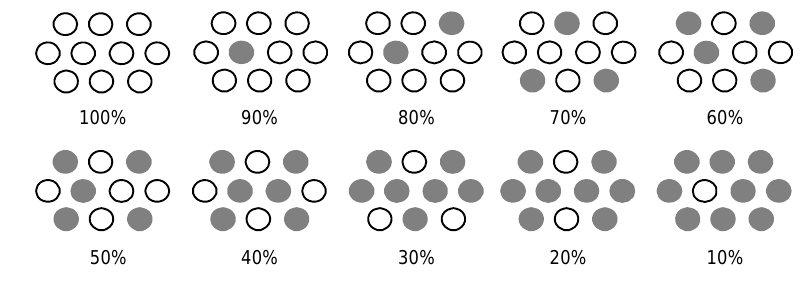
Figure 14. Typical arrangements of the dye ( ○ ) and spacer ( ● ) molecules on the TiO surface formed during the processes of dilution of the former with the latter (reprinted from [10], Copyright (2005), with permission from